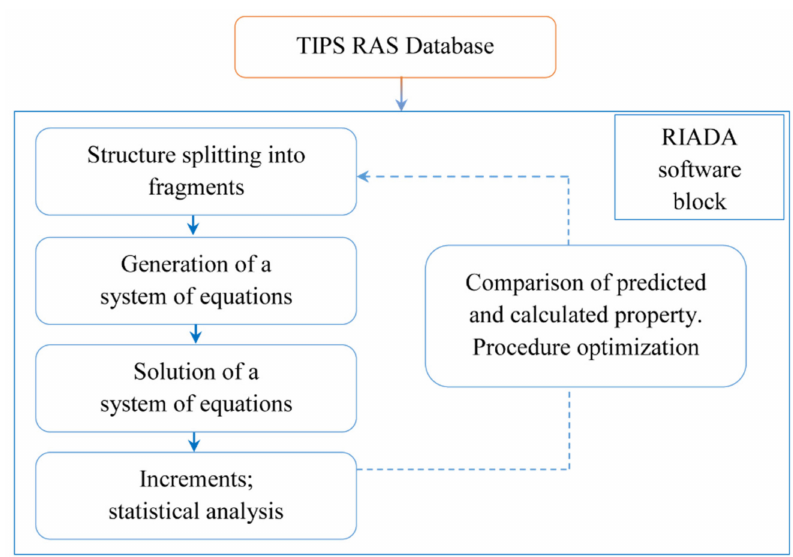
Figure 3. Universal flowchart for group contribution methods (MAC and